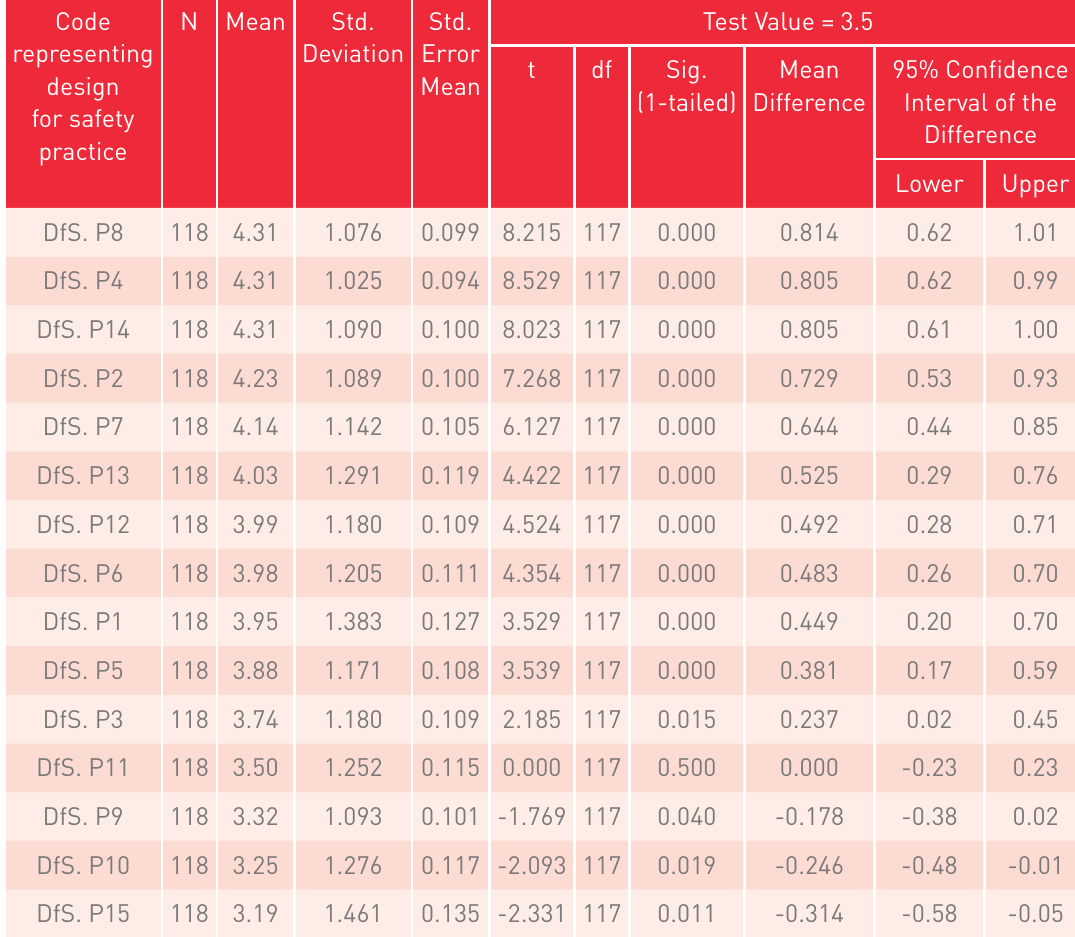
Table 7. Results for one sample t-test for the frequency of engagement in DfS